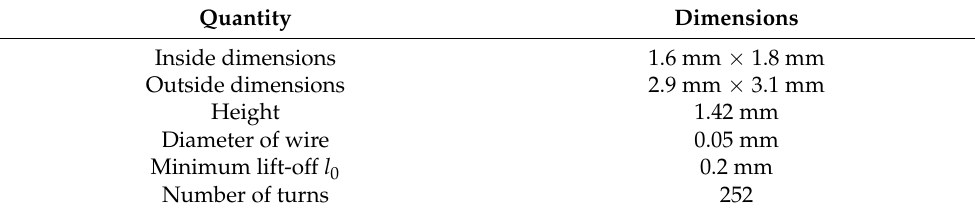
Figure 2. The gradiometer EC probe with a half-bridge GMR sensor chip. ( a ) Photographs of the encapsulated probe. The outer diameter of the stainless-steel housing tube is 4 mm. ( b ) The structure of the probe. Table 1. Geometric parameters of the excitation